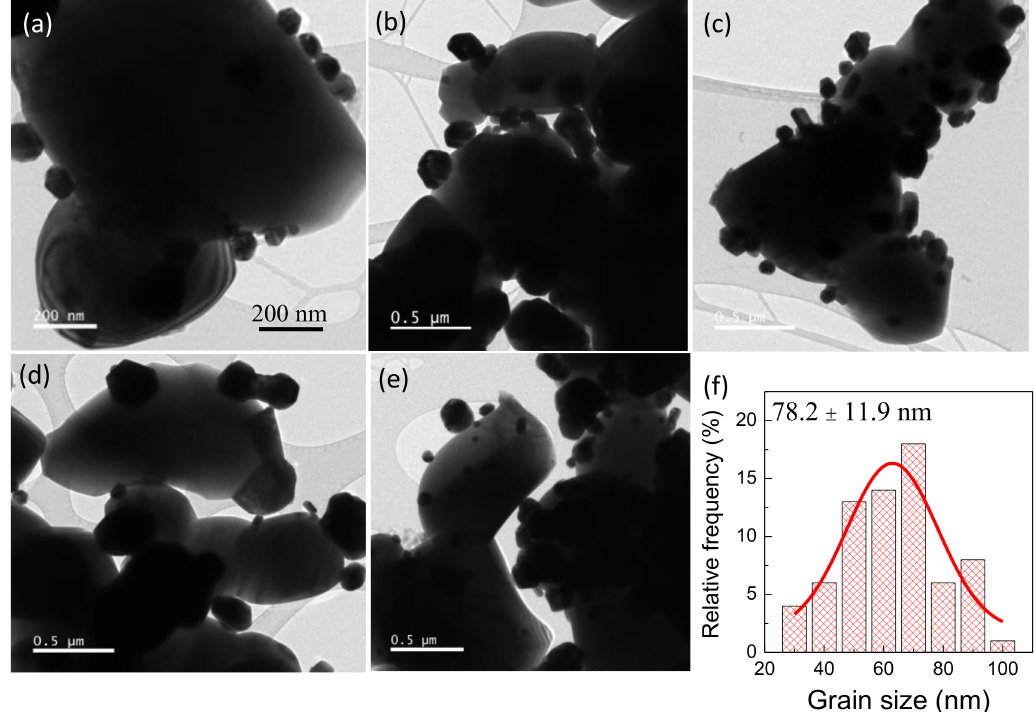
Figure 1. ( a – e ) TEM images of Ag–INTO hybrid particles prepared by a seed-mediated growing process; ( f ) size distribution of Ag–INTO